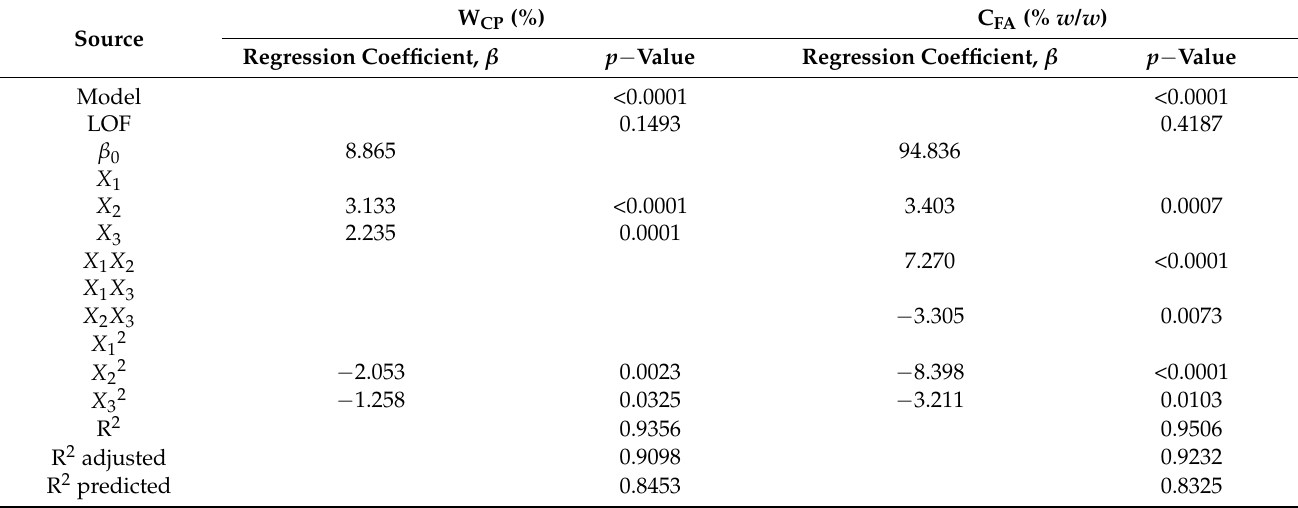
Table 3. Regression coefficients of the reduced mathematical models with their statistical significance and model parameters for blackcurrant seed extraction yield (W CP ) and fatty acid content (C FA